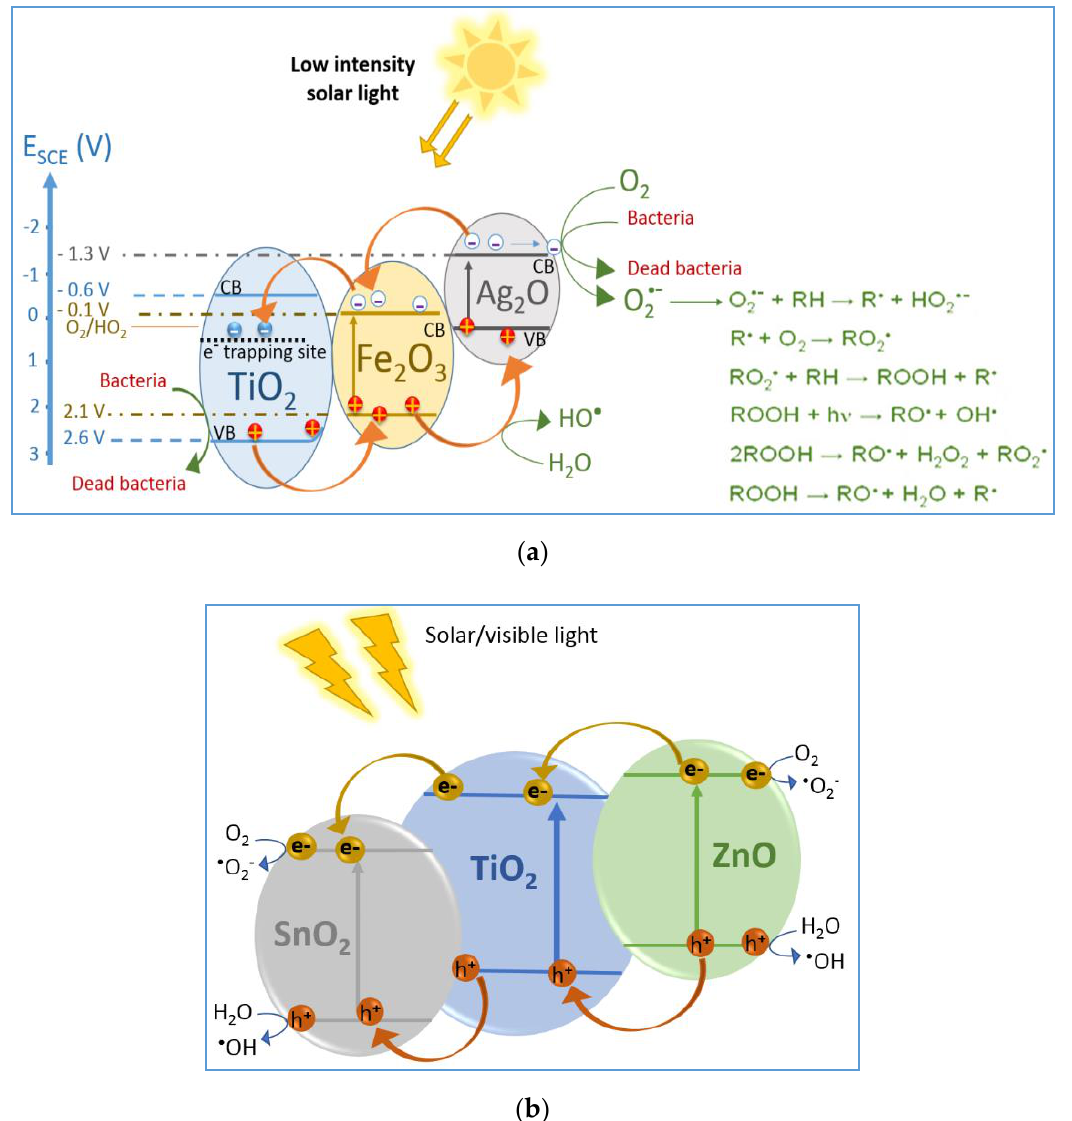
Figure 10. ( a ) Ag(3%)-TiO 2 -FeOx(3%) ternary photocatalyst being irradiated by visible light. The interfacial charge transfer (IFCT) within the composite photocatalyst is shown as a function of their relative potential energy levels leading to the bacterial inactivation process. ( b ) IFCT and electron transfer mechanism for the stable ternary semiconductor photocatalyst made up of TiO 2 /SnO 2 /ZnO.